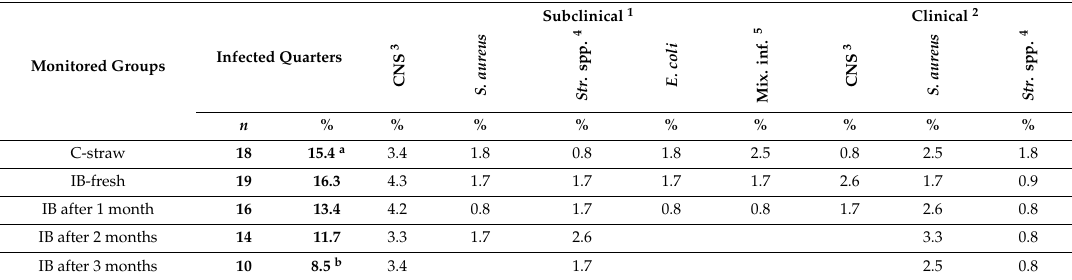
Monitored Groups